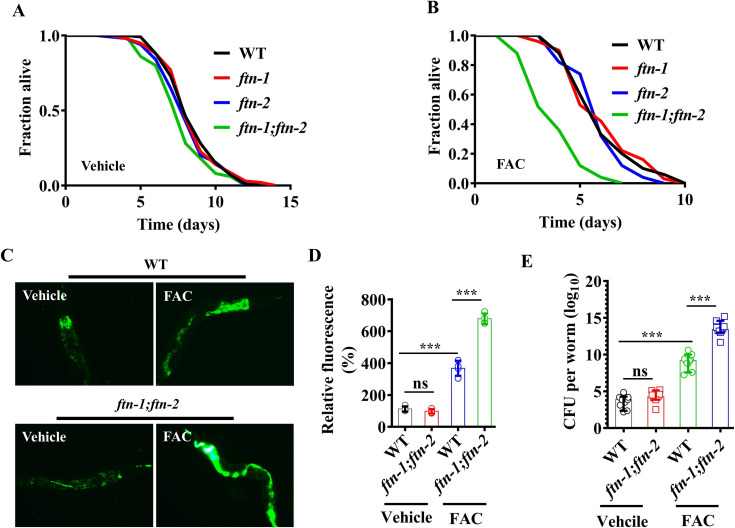
Ferritin is required for defense against S. Typhimurium infection in worms in the presence of exogenous iron.(A and B) The survival of ftn-1(ok3625), or ftn-2(ok404), or ftn-1(ok3625);ftn-2(ok404) double mutants after S. Typhimurium infection in the absence (A) or presence (B) of ferric ammonium citrate (FAC, 100 μM). P< 0.01, ftn-1;ftn-2 relative to wild-type (WT) worms in the presence of FAC (Log-rank test). Underlying data are available in S1 Table. (C) Representative images of ftn-1(ok3625);ftn-2(ok404) double mutants exposed to S. Typhimurium expressing GFP for 48 h in the absence or presence of FAC. (D) Fluorescence intensity of S. Typhimurium expressing GFP. These results are mean ± SD of four independent experiments performed in triplicate (n = 15 worms per experiment). ***P < 0.001; ns, not significant (one-way ANOVA followed by a Student-Newman-Keuls test). Underlying data are available in S2 Table. (E) The colony forming units (CFU) of S. Typhimurium were measured in worms in the absence or presence of FAC. These results are mean ± SD of 6 independent experiments for the ftn-1;ftn-2+FAC group, 10 independent experiments for WT+Vehicle, ftn-1;ftn-2+Vehicle, and WT+FAC groups (n ≥ 50 worms per experiment). ***P< 0.001; ns, not significant (one-way ANOVA followed by a Student-Newman-Keuls test). Underlying data are available in S2 Table.